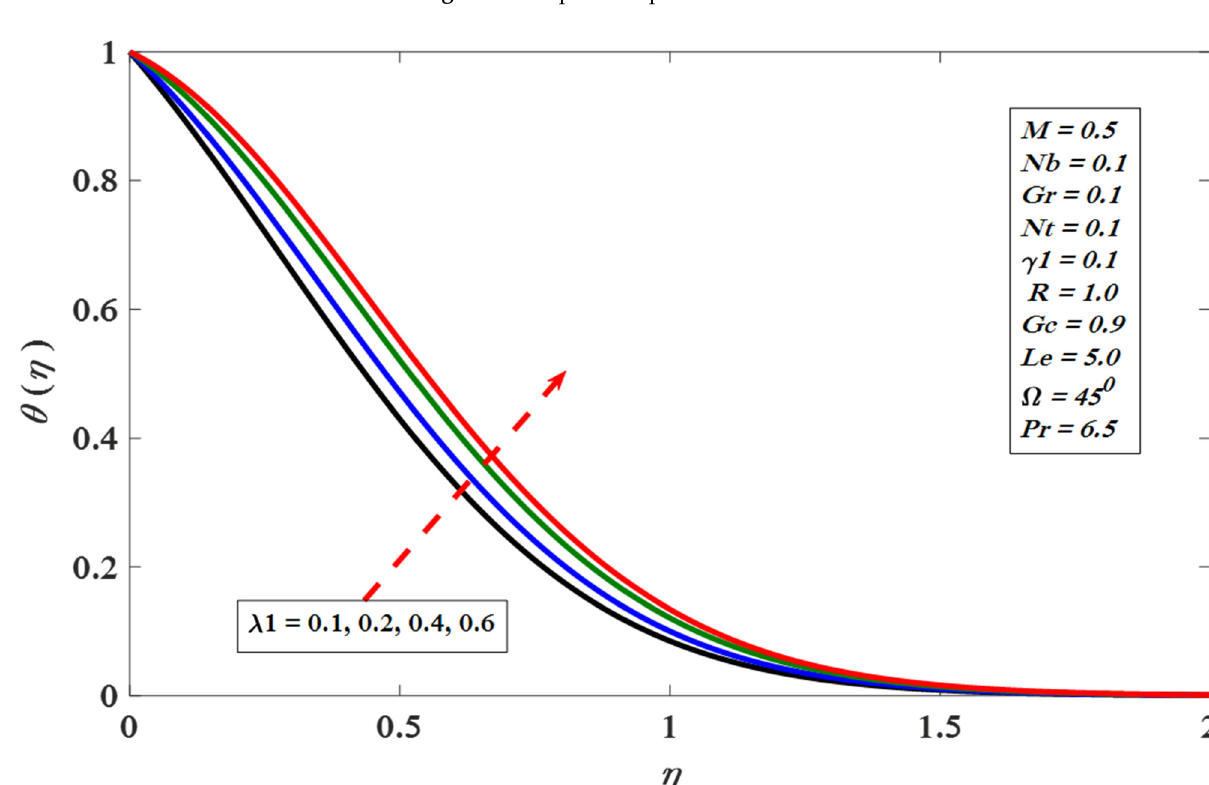
Figure 7. Temperature profile versus M .